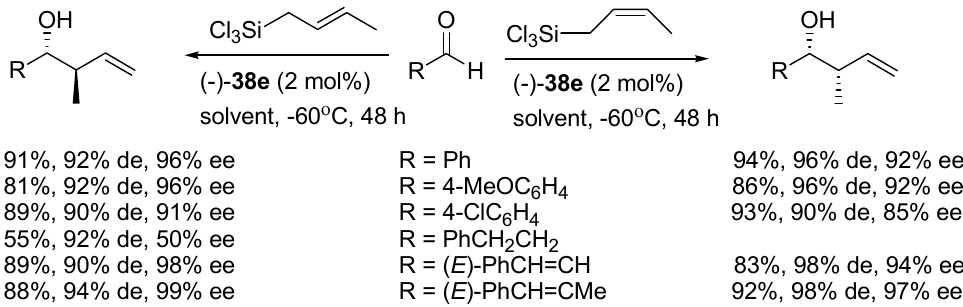
Scheme 9. Asymmetric crotylation of aldehydes with (-)- 38e .